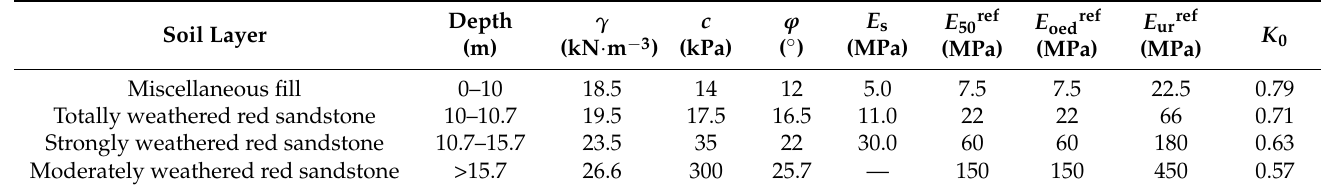
Table 1. Mechanical parameters of